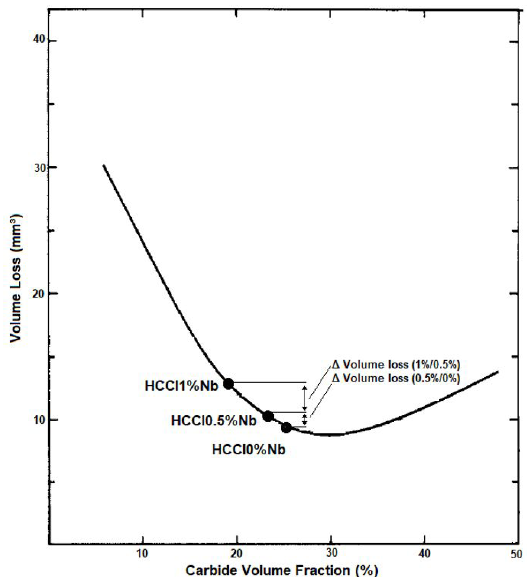
Figure 13. Positioning of alloys in an adapted curve by Zum Gahr and Eldis (1980)*. *The positioning illustrates the alloys expected behavior, disregarding NbC carbides effect. The magnitude of 0.75 worn volumes cannot be directly compared to the present work due to variations between test parameters, such as time, size, and abrasive shape.